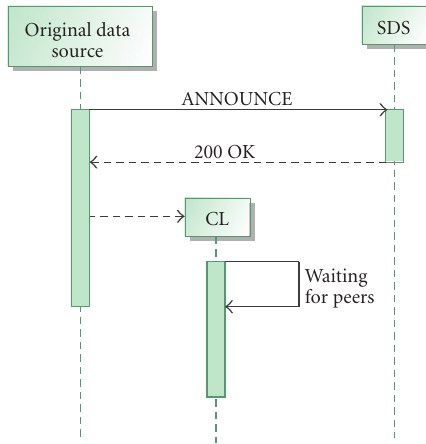
Figure 2: Creation of the service and the initial